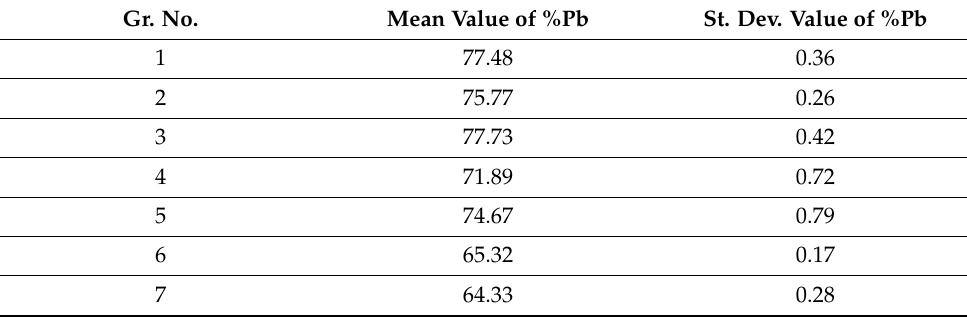
Table 3. Variations in %Pb content in the modified groups.